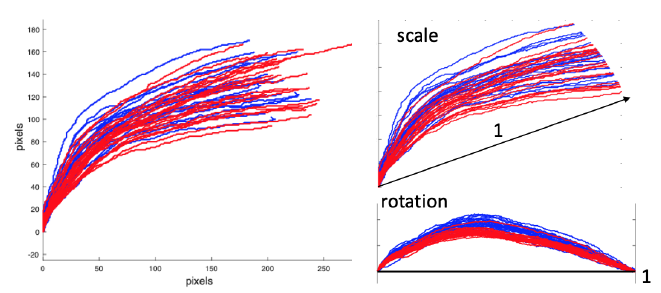
Figure 8. Representation of the scale and scale-&-rotation effects on the original Red Mullet contours. These changes are performed during the contour normalization